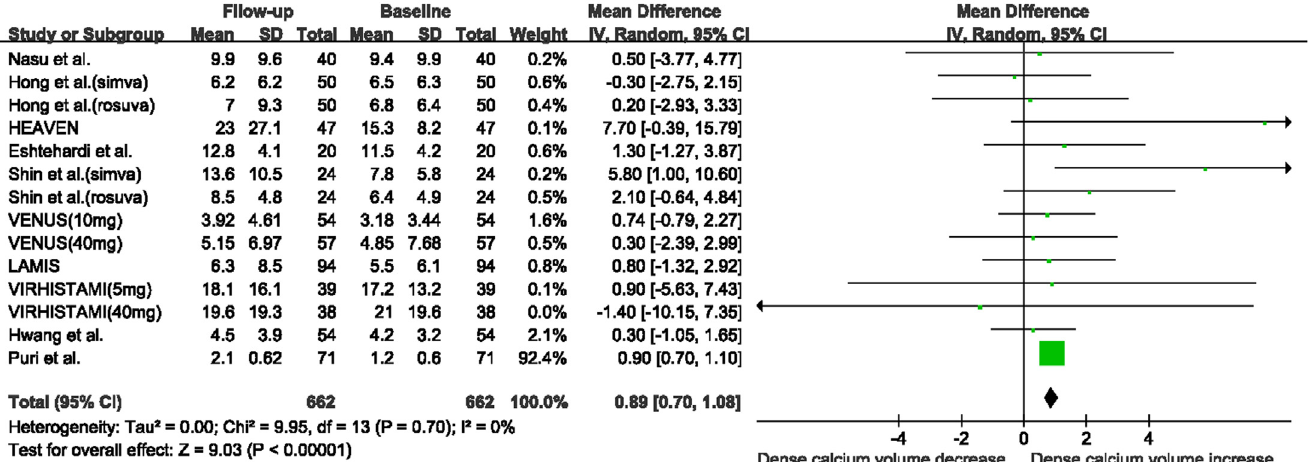
PLOS ONE | DOI:10.1371/journal.pone.0133433 July 30,